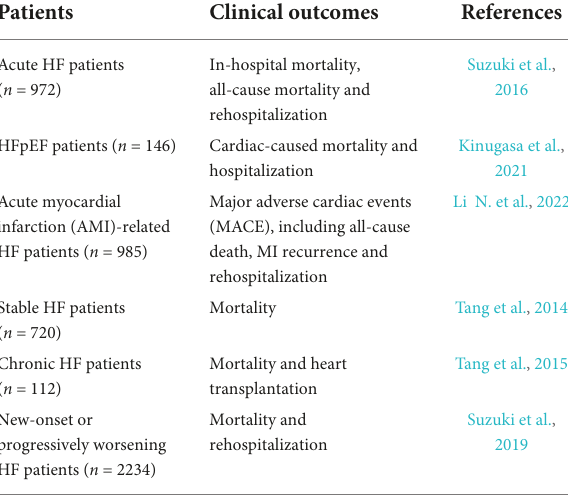
TABLE 1 Studies on predictive values of TMAO for HF clinical